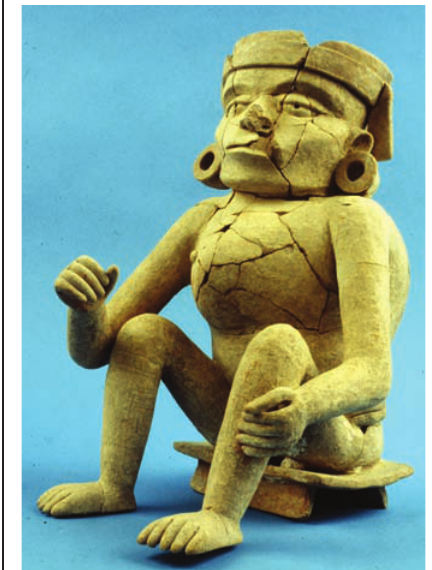
Figure 4 David Pendergast excavated this spectacular vessel depicting a hunchbacked man from one of latest elite tombs at Lamanai, probably dating from the late 15th to early 16th century.